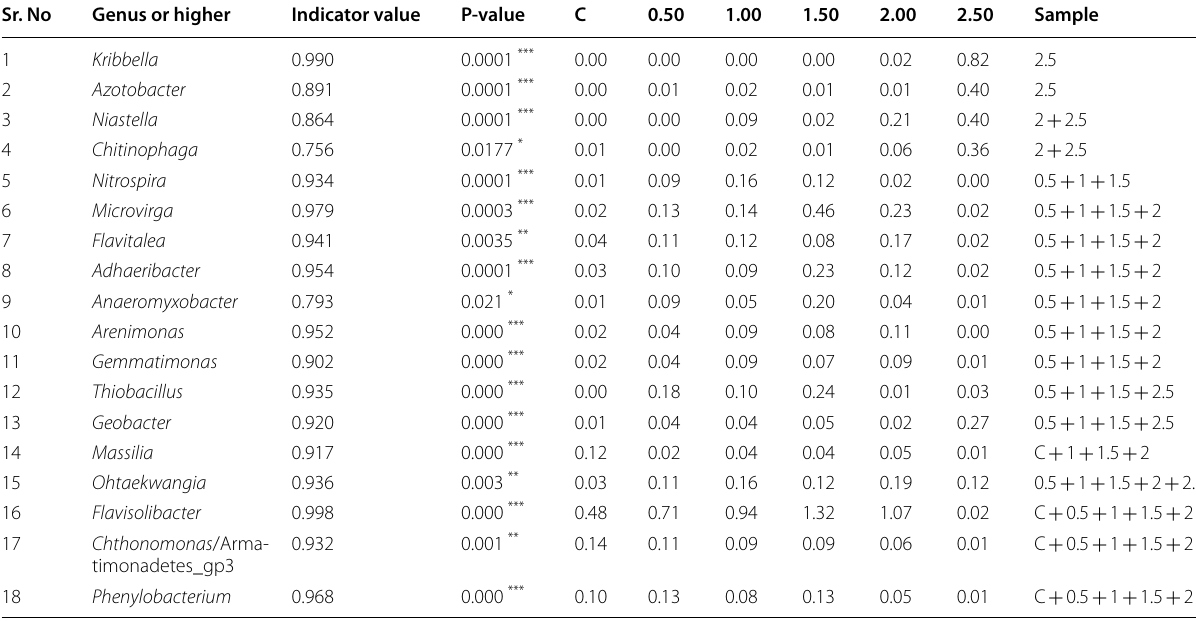
Dufrene-Legendre indicator species analysis (Indval) was used for calculation of associations in R. The data shows indicator species from top 400 OTUs representing average relative abundance in non-amended and sclerotia-amended soil samples Significance levels: